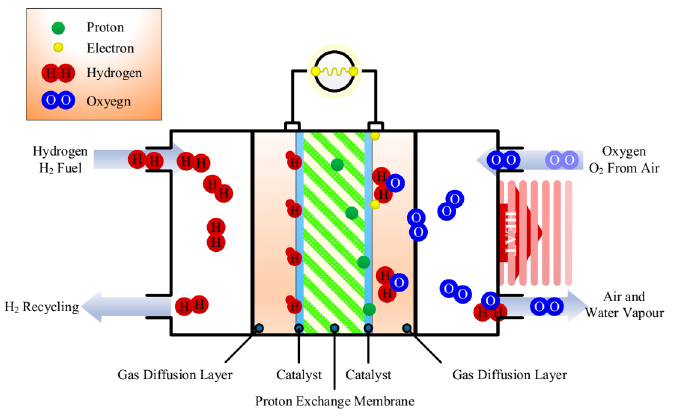
Figure 1. Chemical reaction in proton exchange membrane fuel cell